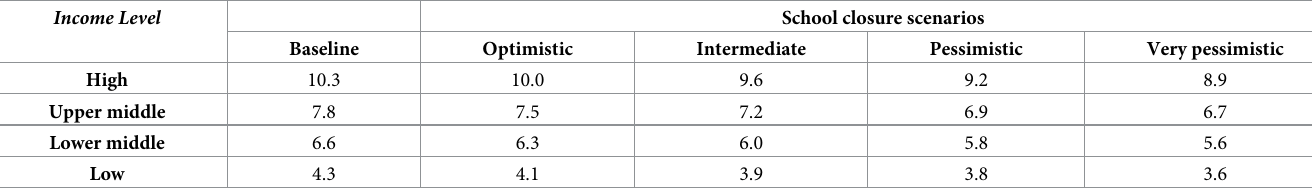
Table 1. The effect of school closures on Learning-Adjusted Years of Schooling (LAYS).